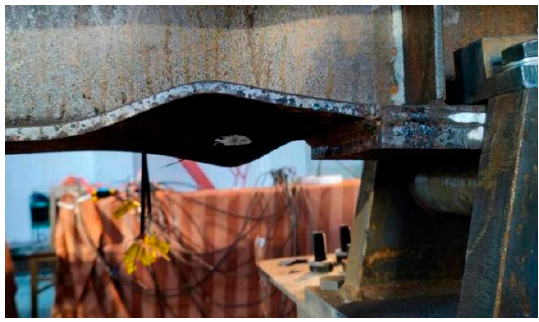
Figure 8. Buckling of the bottom flange of CSB-1.